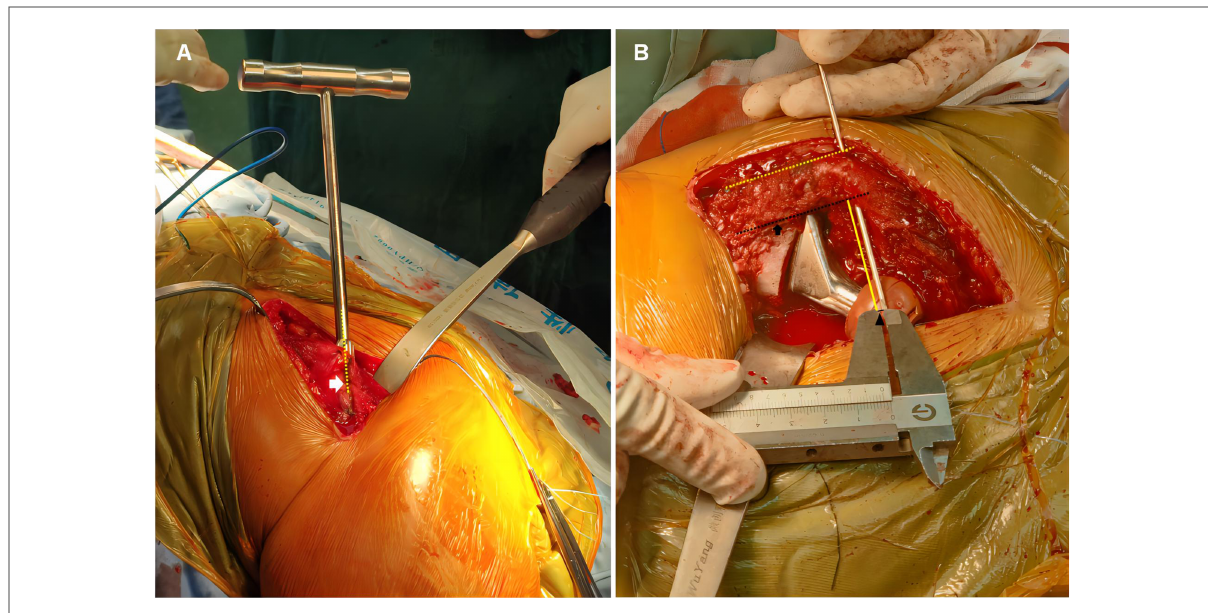
FIGURE 3 Intra-operative photograph. ( A ) Marking the line parallel to the reamer on the lateral of proximal femur for double checking (white arrow and yellow dotted line). ( B ) Measure the vertical distance from the center of the femoral head to the tip of the greater trochanter on the anatomical axis of the femur (black solid line and black arrowhead) and femoral offset (yellow solid line). Making the line parallel to the reamer on the lateral of proximal femur (yellow dotted line) and on the proximal femur representing long axis of femur (black arrow and black dotted line).